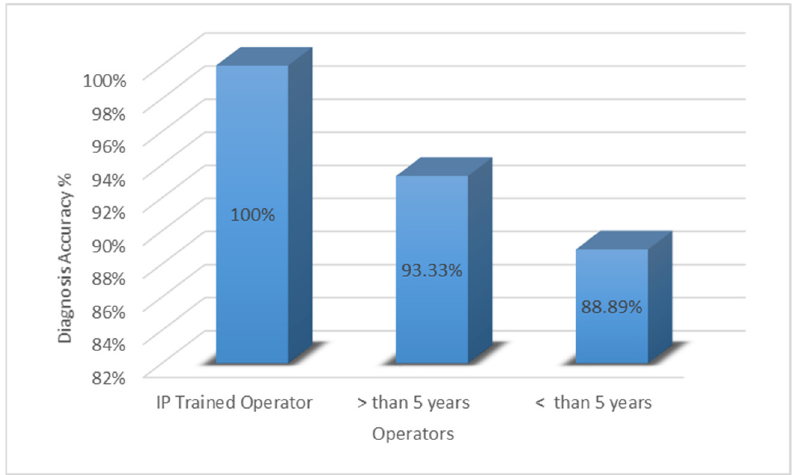
Figure 1. Inter-operator diagnostics accuracy. The diagnostic accuracy (%) is shown on the y-axis and the operator experience is shown on the x-axis.